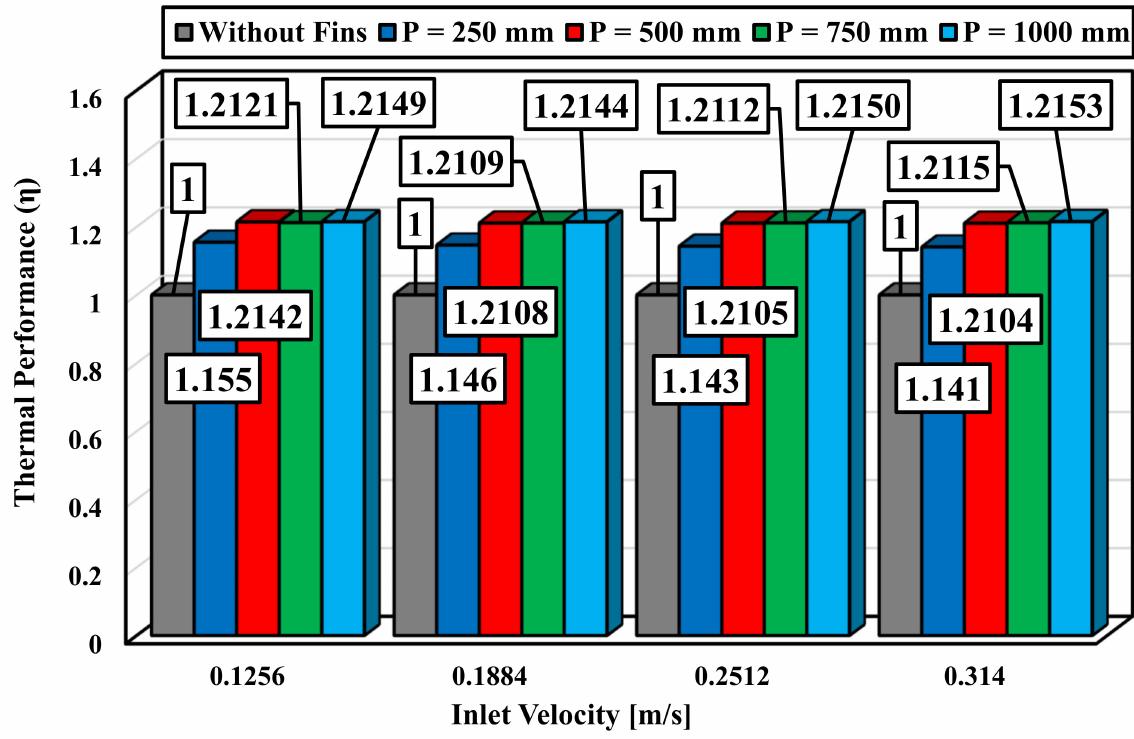
Figure 17. The thermal performance ( η ) versus various inlet velocities for different